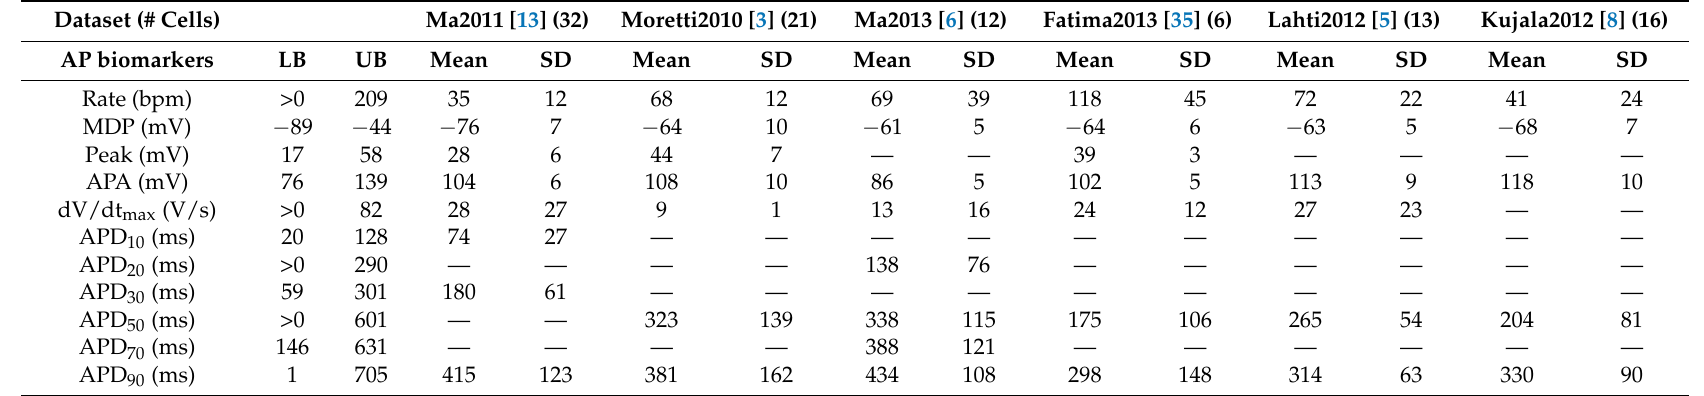
Table 5. Datasets used for calibrating the random populations. Lower (LB) and upper (UB) bounds for each AP biomarker are reported in columns two and three. Missing data are marked as —. This table has been reproduced from the Supplementary Material of